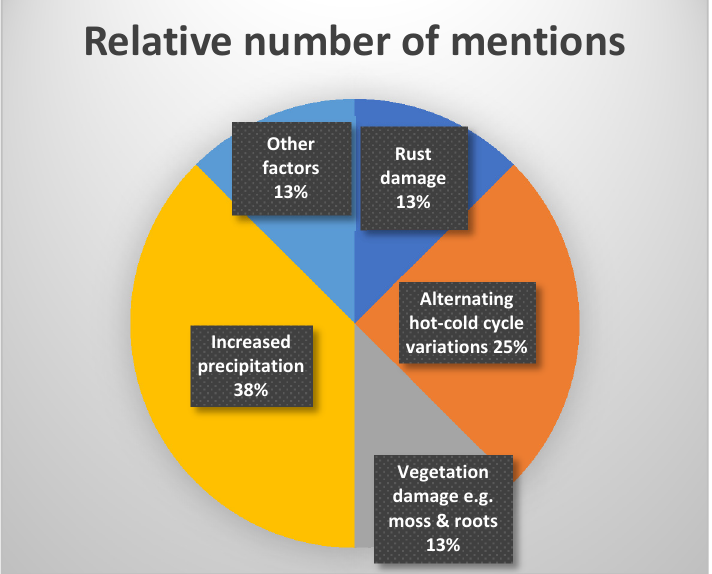
Figure 3. Observations of urban planners dealing with climate change damage factors in the cul- tural environment.